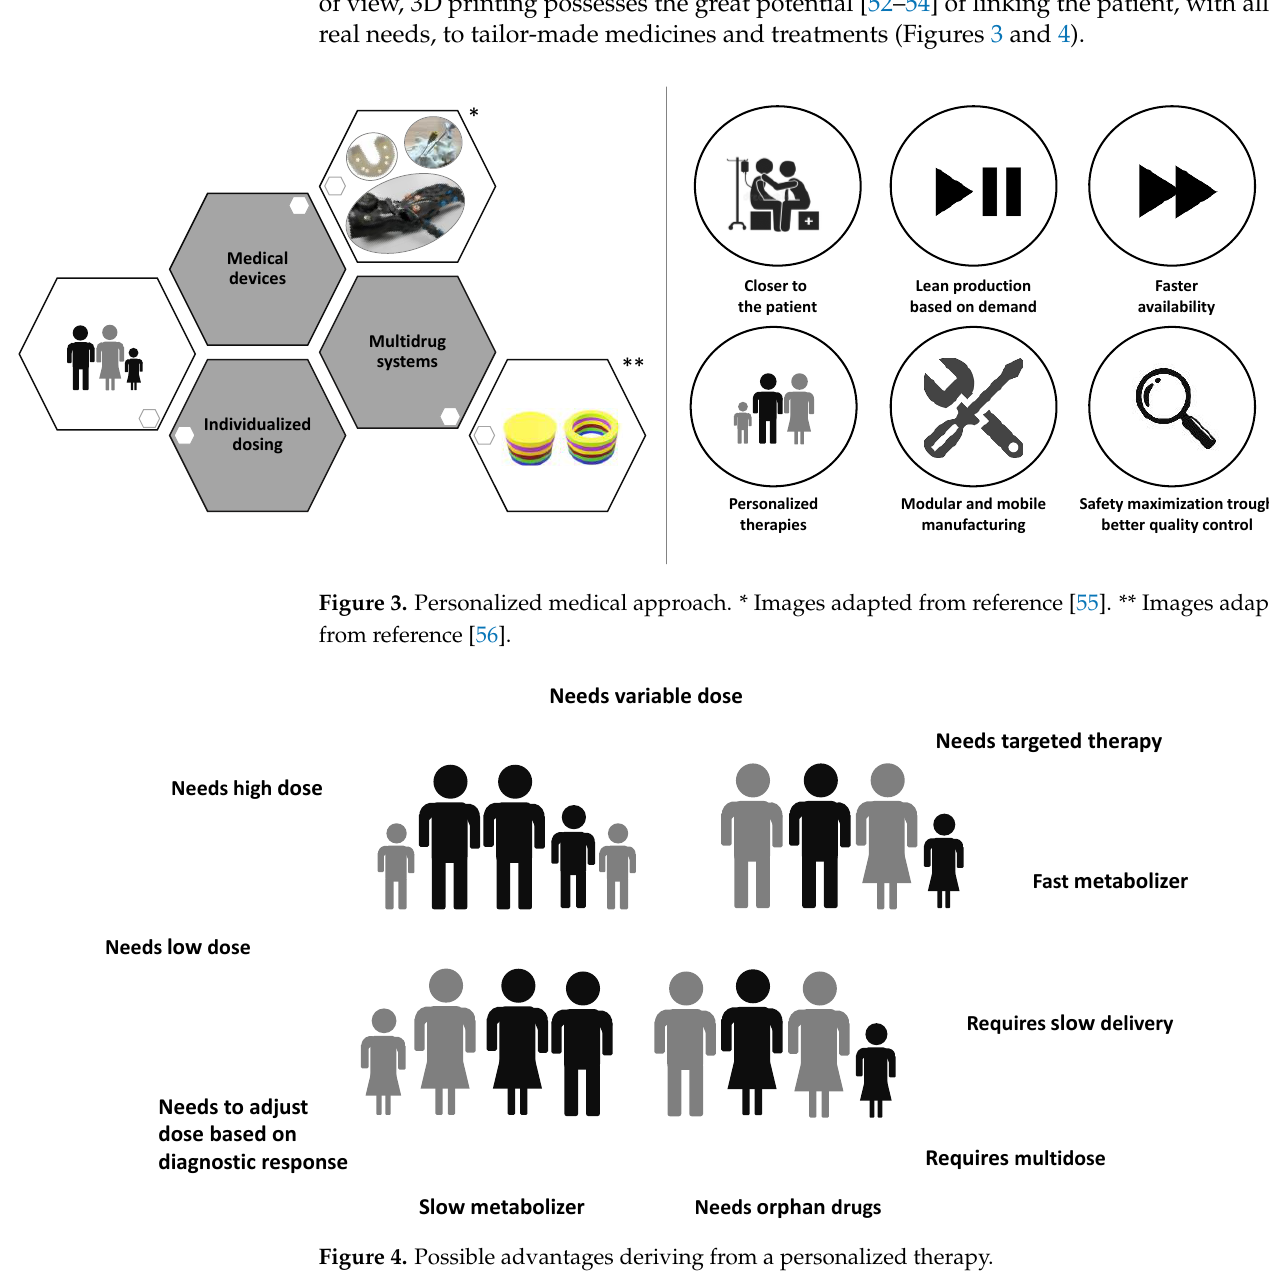
Figure 4. Possible advantages deriving from a personalized therapy.